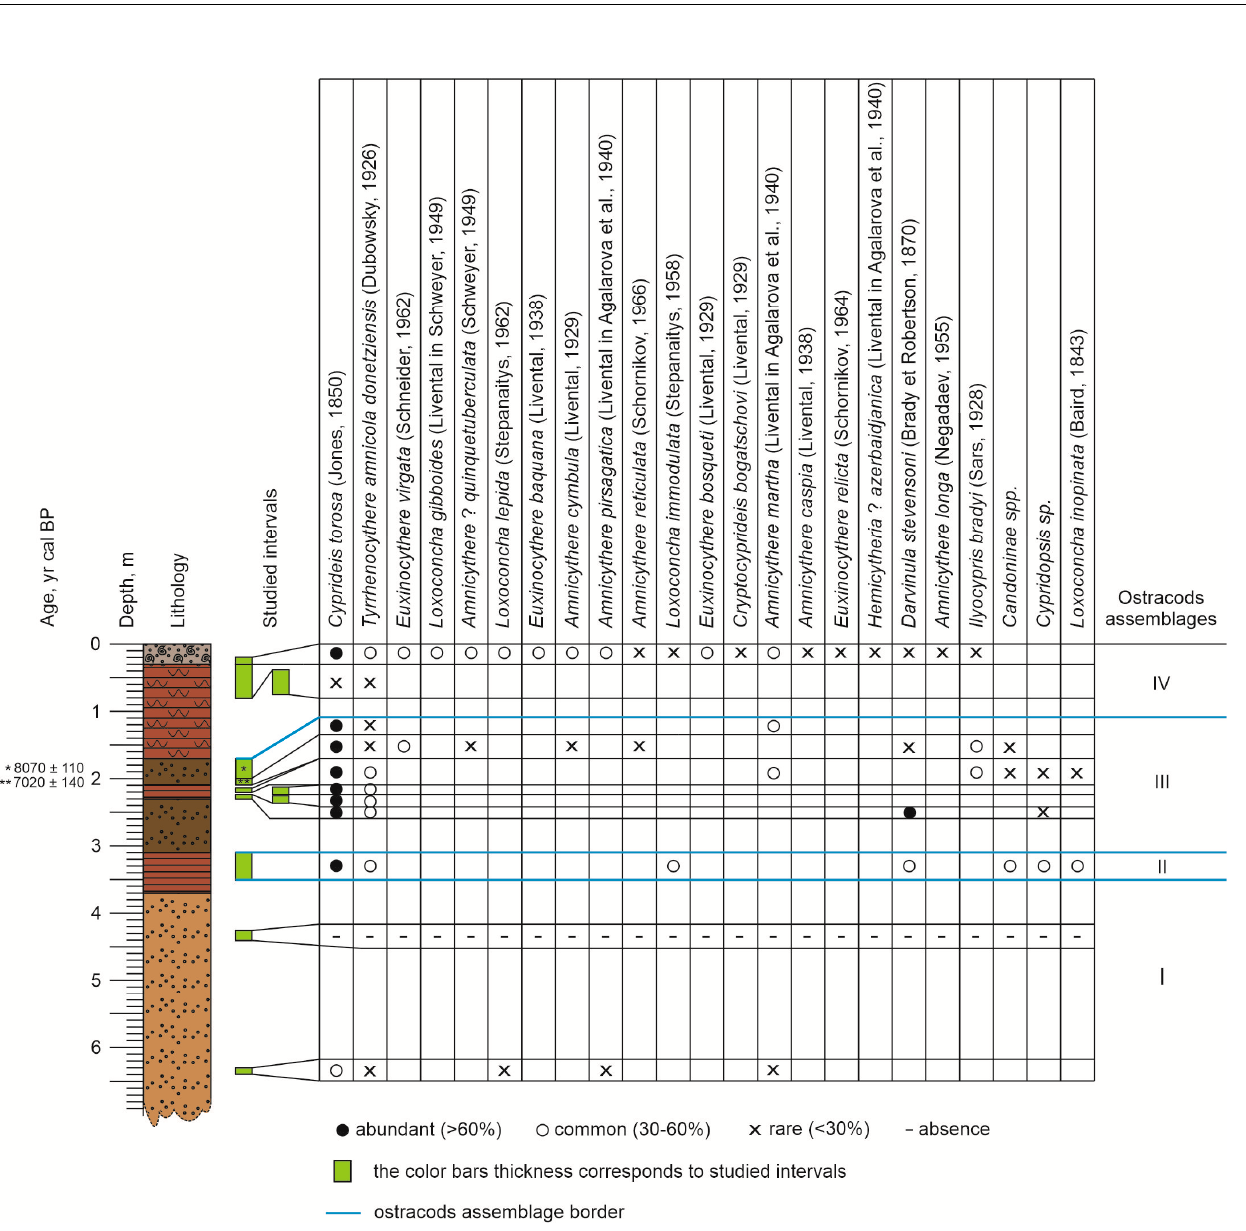
Figure 9. Rybachya core list of ostracods (grouped from left to right from marine/brackish water to freshwater species).